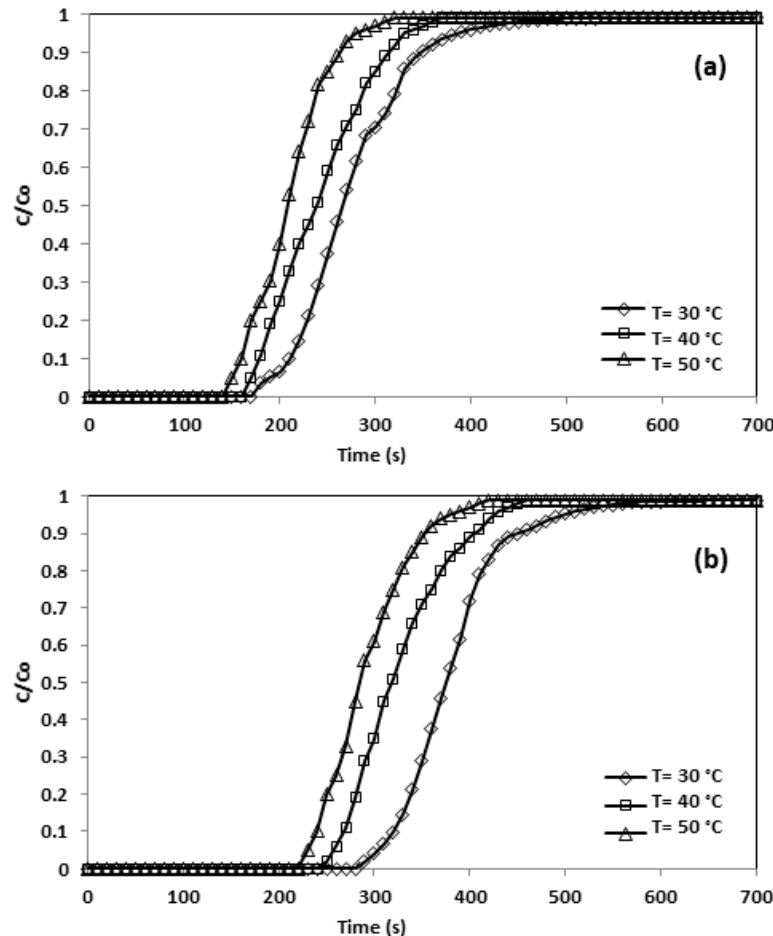
Figure 13. Breakthrough curve and effect of temperature ( a ) CNFCM and ( b ) Modified CNFCM in constant P = 1 bar, and 10% CO 2.